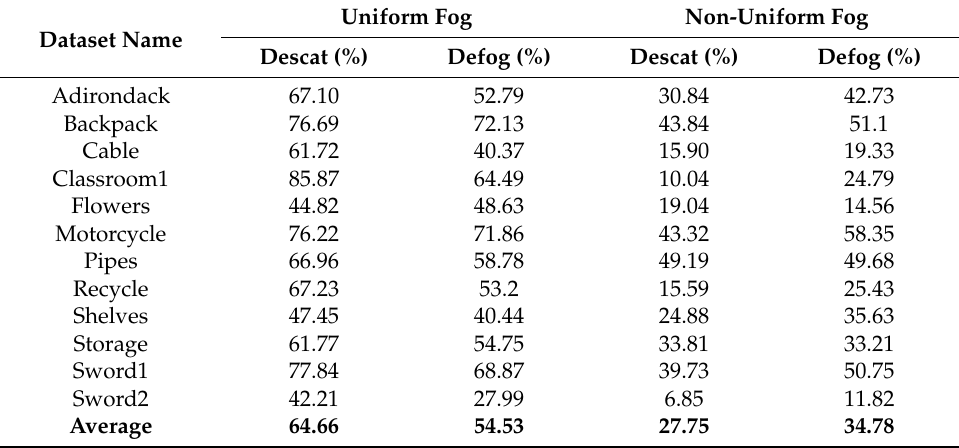
Table 1. Correct matching rate from proposed descattered and defogged